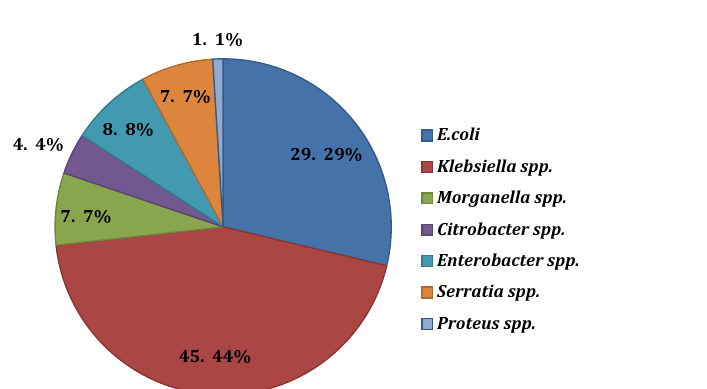
Table 1. Bivariate analysis of general characteristics, therapeutic devices and procedures performed, and use of antibiotics potentially associated with carbapenem-resistant Enterobacterales acquisition. a The results shown are with no subsequent carbapenem prescription.